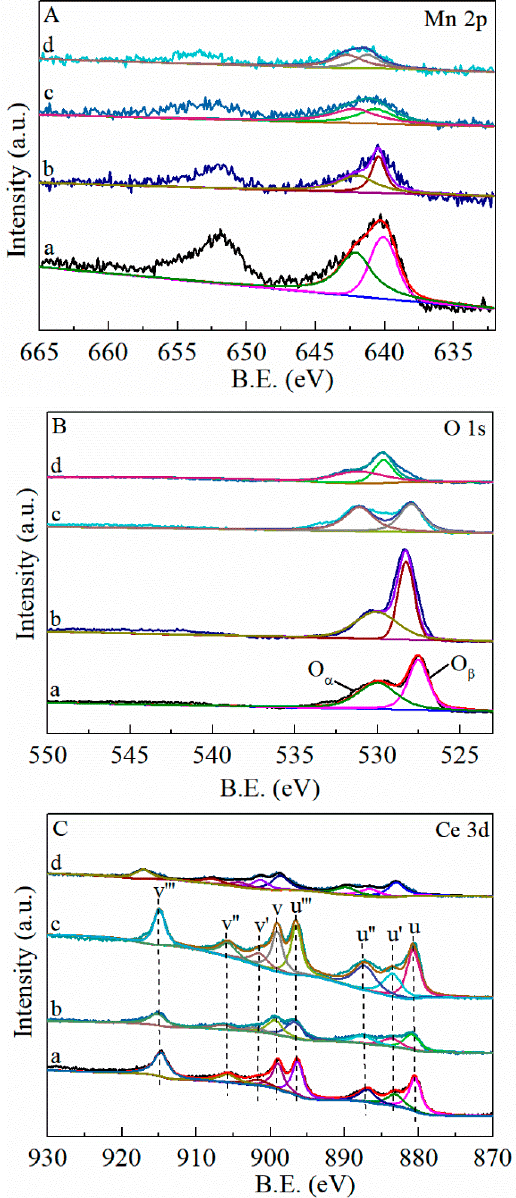
Figure 7. XPS spectra of (a) MnO 2 -CeO 2 , (b) FMC-1:5:5, (c) FMC-2:5:5 and (d) FMC-3:5:5. ( A ) Mn 2p, ( B ) O 1s, ( C ) Ce 3d. O α represent the surface-absorbed oxygen, O β represent the surface lattice oxygen. The peak u (880.6 eV), u’ (883.3 eV), u ″ (887.0 eV), u ‴ (896.3 eV), v (899.1 eV), v ′ (901.7 eV), v ″ (905.7 eV) and v ‴ (914.7 eV). Table 4. Surface elemental composition of FMC catalysts.